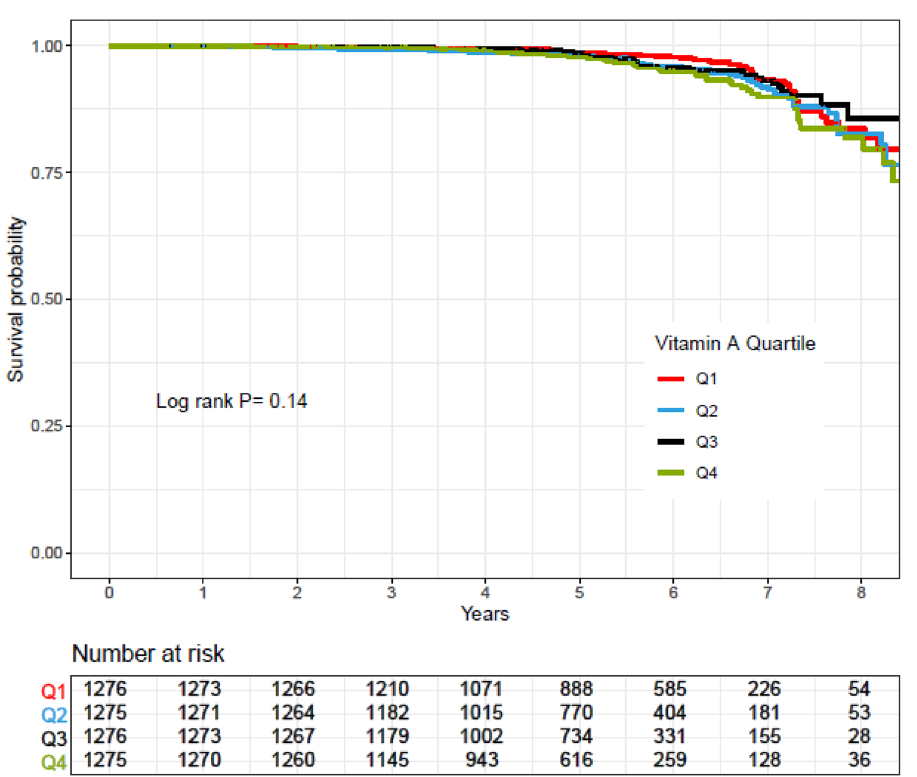
Figure 4. Kaplan–Meier estimates of CVD-free survival according to quartiles of vitamin A intake. P values by log-rank test and number of CVD outcomes recorded in the groups categorized by vitamin A